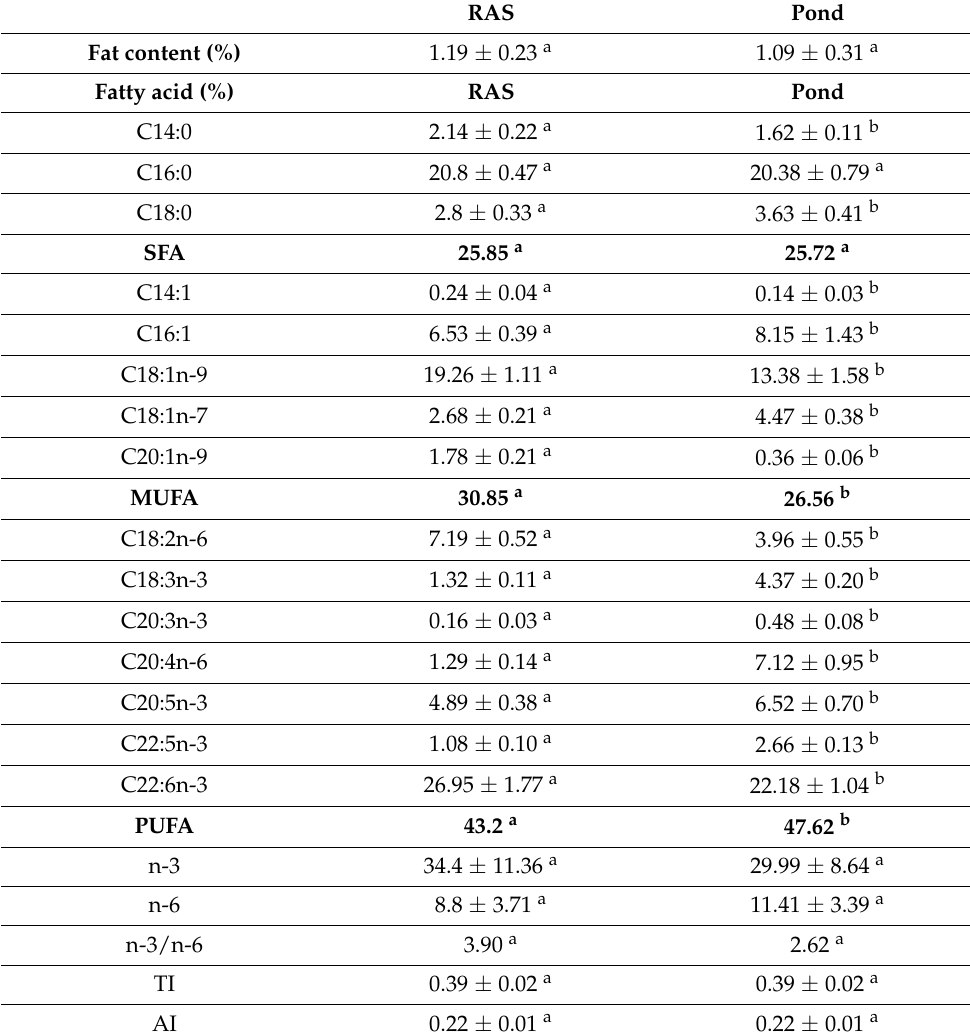
Table 1. Fat content (%) and fatty acids composition (%) of Eurasian perch fillets from RAS and pond rearing systems (mean ± S.D., n =